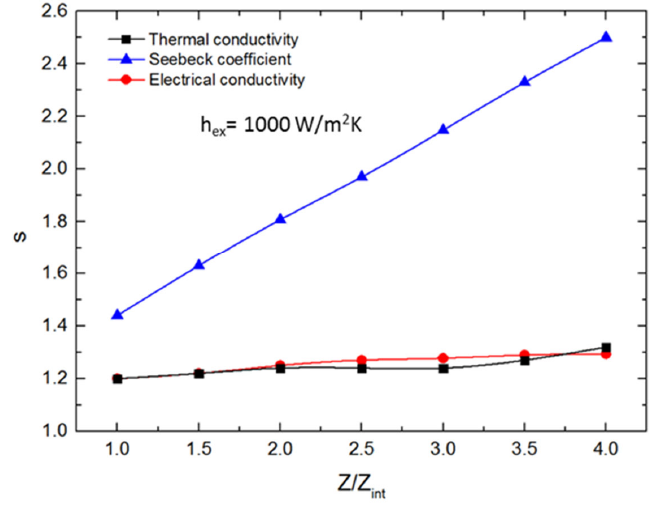
Z for different values of h ex for different values of ℎ (cid:3032)(cid:3051) . Figure 8. s ratio as a function of Z int (cid:3027) (cid:3284)(cid:3289)(cid:3295)